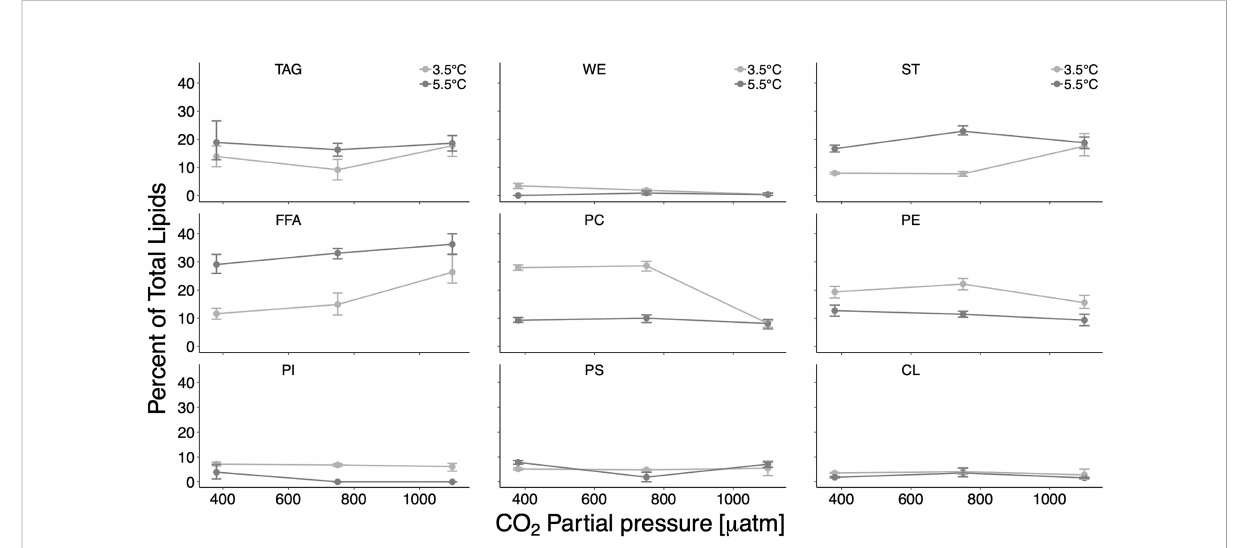
FIGURE 2 Percent contribution of each lipid class on the total lipid content (total lipids) per individual. TAG, triacylglycerol; WE, wax ester; ST, sterols; FFA, free fatty acids; PC, phosphatidylcholine; PE, phosphatidylethanolamine; PI, phosphatidylinositol; PS, phosphatidylserine; CL, cardiolipine. Error bars depict 95% con fi dence